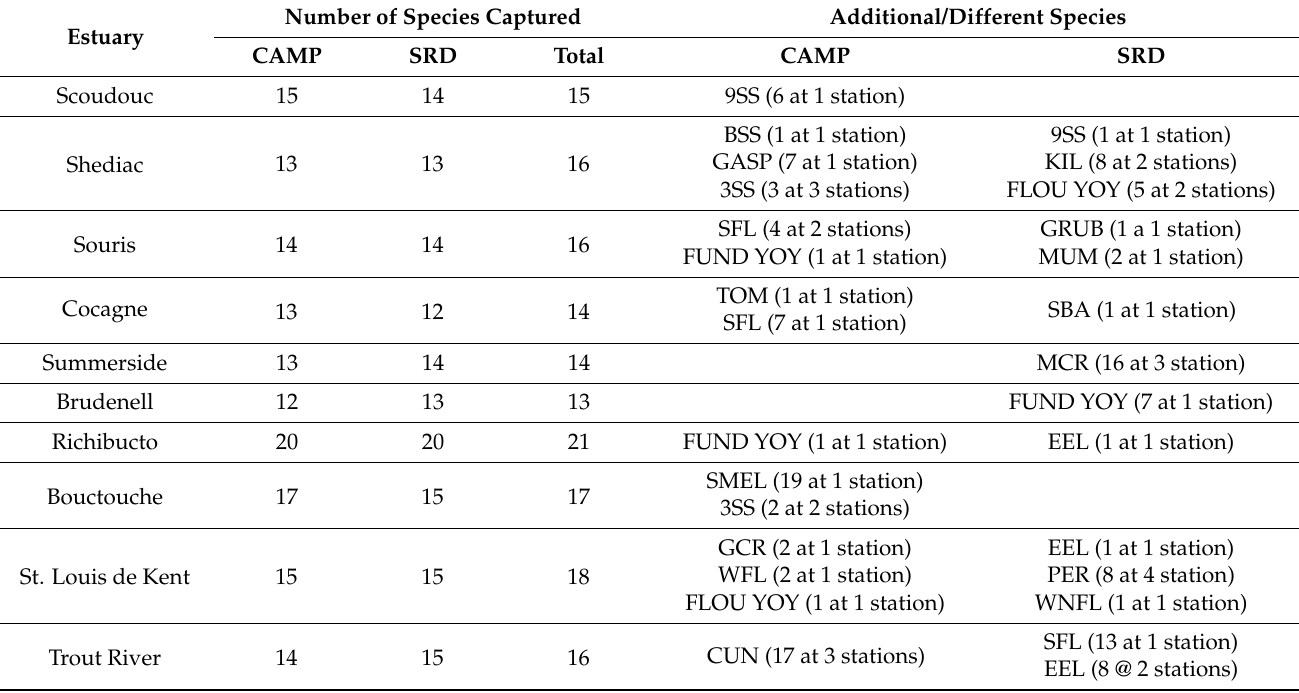
Table 5. Number of species captured by each sampling design (Community Aquatic Monitoring Program [CAMP] and